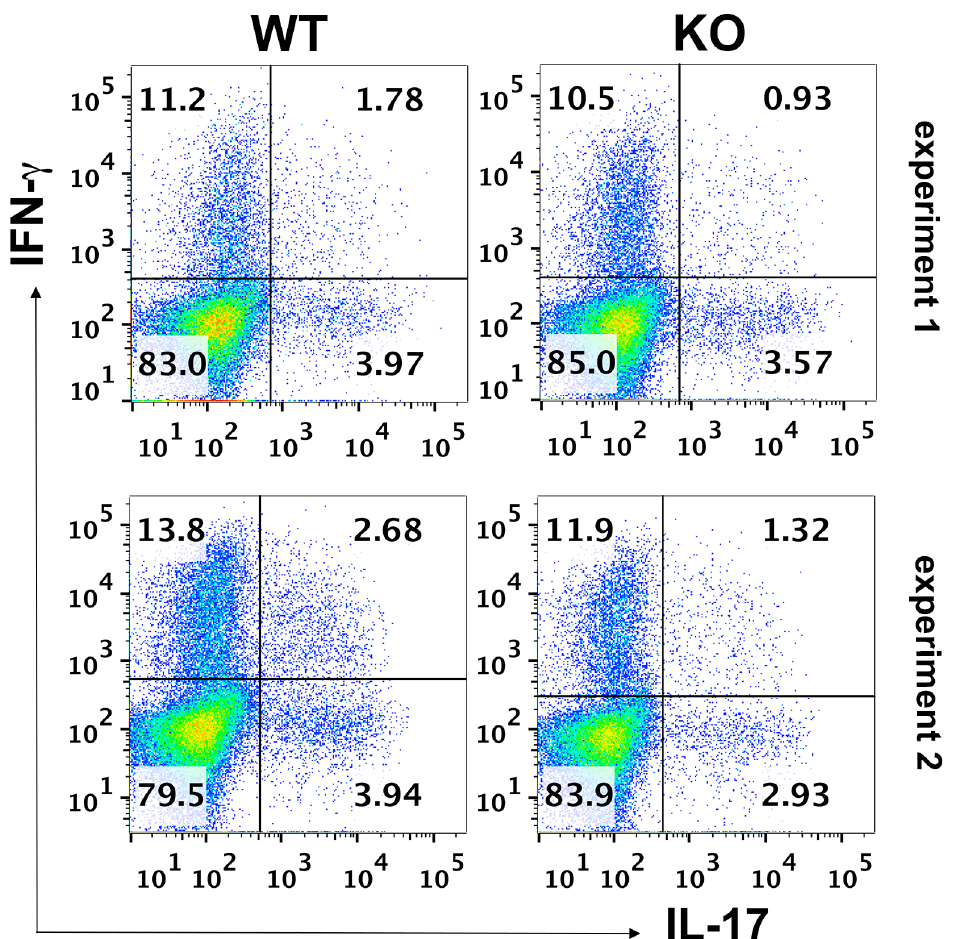
Fig 2. Generation of Th1 and Th17 polarized cells in Lrrk2 (-/-) ( “ KO ” ) mice is moderately less vigorous than in their WT controls. Suspensions of pooled spleen cells of mice of the two groups, 14 days post immunization with IRBP, were examined by flow cytometry for intracellular staining with antibodies against IFN- γ or IL-17, the signature cytokines for Th1 and Th17, respectively. Data of two individual